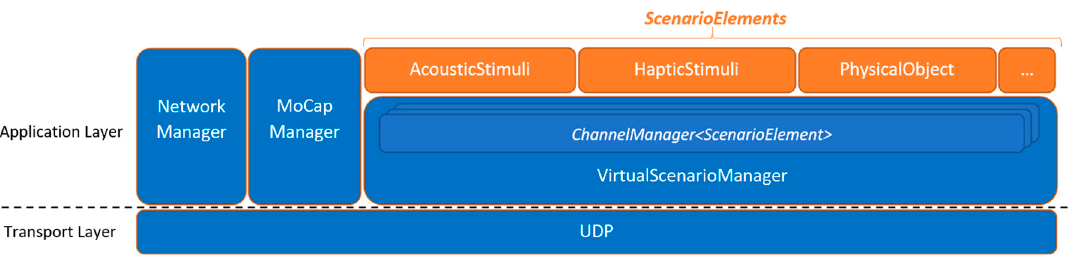
Figure 2. Communication protocol.